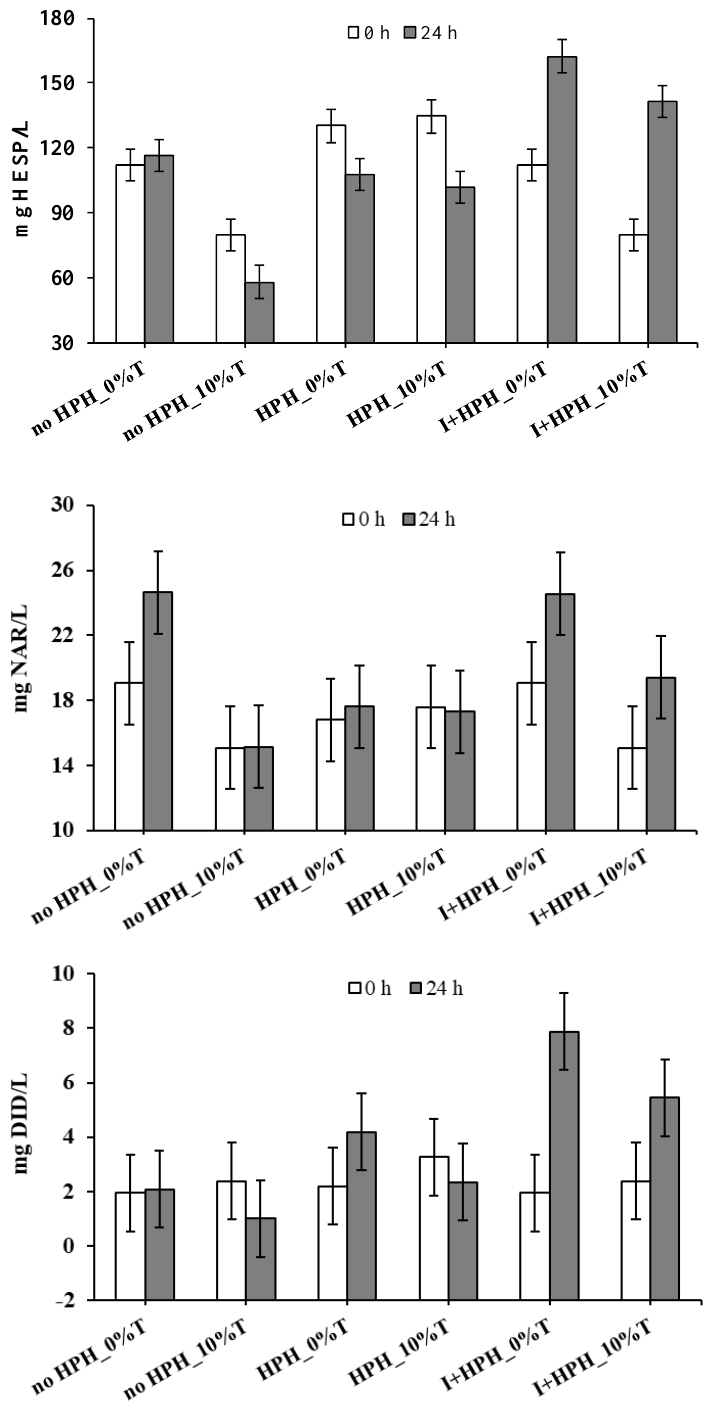
Figure 2. Hesperidin (HESP), narirutin (NAR) and didymin (DID) content in the juice samples before and after 24 h of fermentation at 37 °C. Graphs of means and LSD intervals for a confidence level of 95%.